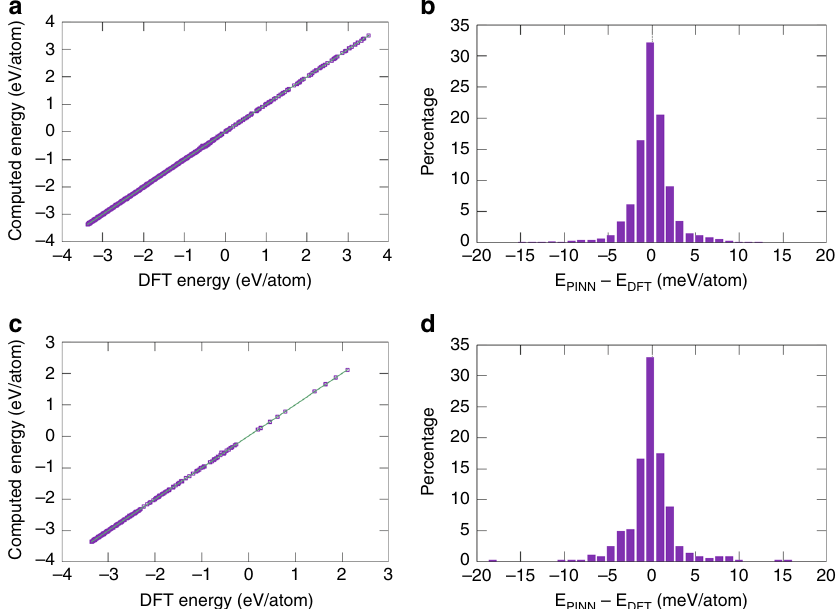
Fig. 2 Accuracy of the PINN potential. a , c Energies of atomic con fi gurations in the a training and c validation datasets computed with the PINN potential versus DFT energies. The straight line represents the perfect fi t. b , d Error distributions in the b training and d validation